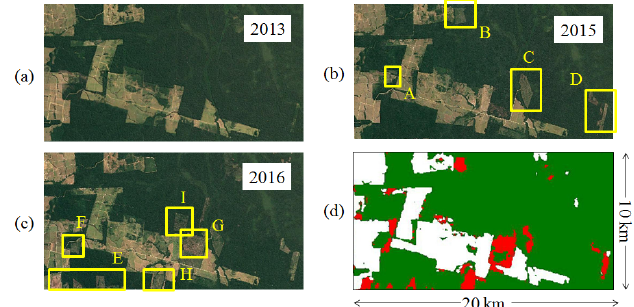
Figure 14. Visual inspection for the validation of the detected clear-cuts from the yellow patch high- lighted in Figure 13. ( a – c ) depict optical Landsat images of the region acquired at the end of 2013, 2015 and 2016, respectively. For each year, the yellow squares identify new clear-cuts. ( d ) shows the corresponding change map derived by differentiating the TanDEM-X CNN-FNF maps of 2013 and